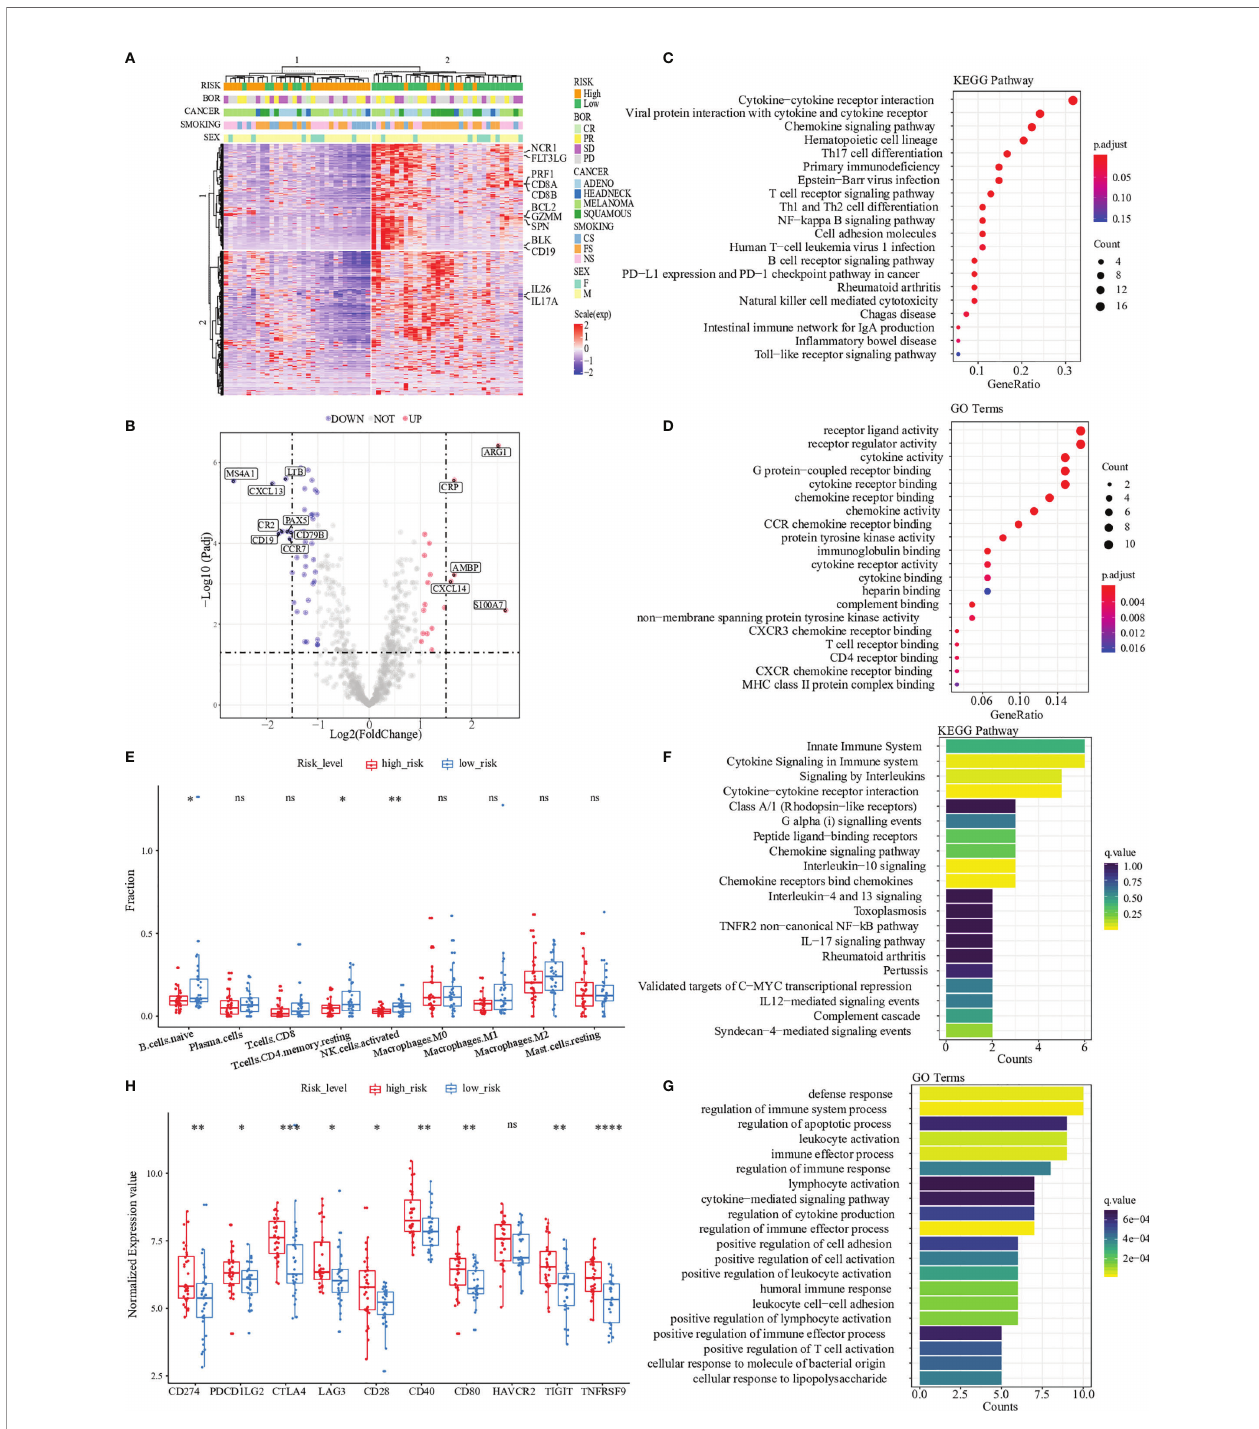
FIGURE 3 | Pathway and gene ontology analysis between two risk groups. (A) Hierarchal clustering analysis of 730 immune-related genes, marked with some markers expressed in CD8+ T cells (PRF1, CD8A, CD8B, GZMM and FLT3LG), CD4+ T cells (IL26 and IL17A), NK cells (SPN, BCL2 and NCR1) and B cells (BLK and CD19). (B) Differential expression analysis between high-risk patients and low-risk patients in the Prat cohort. “ UP ” indicates that the gene was signi fi cantly up- regulated in the high-risk group while “ DOWN ” indicates the gene was signi fi cantly up-regulated in the low-risk group. (C, D) were GO and KEGG enrichment of DEGs, demonstrating that most are related to immune processes. (E) The difference of immune cell in fi ltration abundances between high- and low-risk patients. (F) and (G) were GO and KEGG enrichment of 15 immune-related genes. (H) Different expression in immune checkpoints (CD274, PDCD1LG2, CTLA4, LAG3, CD28, CD40, CD80, HAVCR2, TIGIT, and TNFRSF9) between high- and low-risk patients. '*',P < 0.05.'**',P < 0.01.'***',P < 0.001. ’ **** ’ ,P < 0.0001. “ ns ” , no signi fi